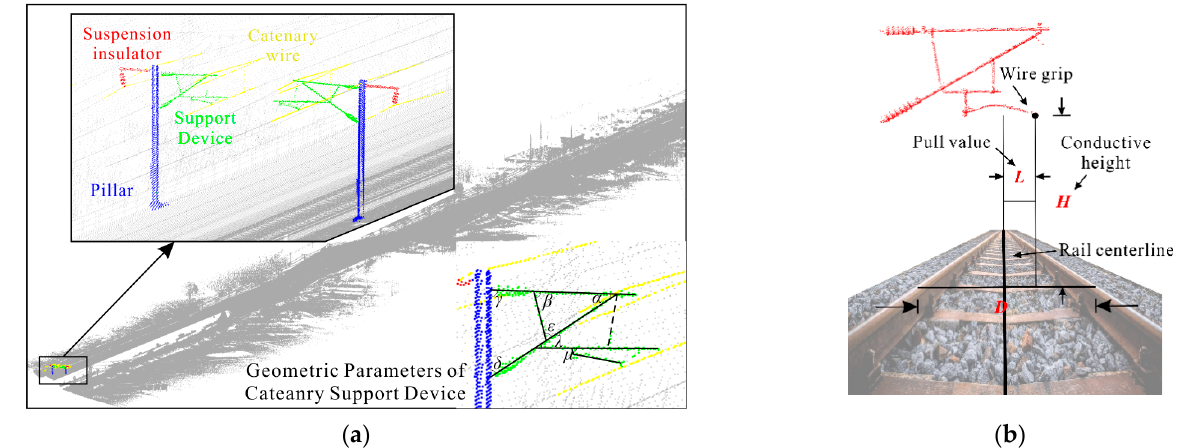
Figure 1. Support device in a complex railway scene and its geometric parameter measurement. ( a ) A support in a complex railway scene. ( b ) The measurement method for some geometric parameters of a railway system.